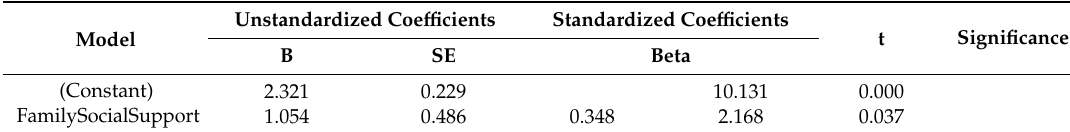
Table 7. Linear regression model for behaviour.